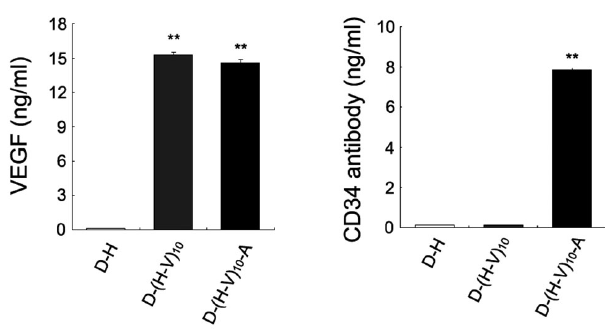
Fig. 2 - Detection of the coated VEGF and anti-CD34 antibody by ELISA. The results of detection of coated VEGF (left) and anti-CD34 antibody (right) by ELISA. Data are reported as mean ± SD for three independent experiments. Statistically significant differences are indicated as **P<0.01, student’s t